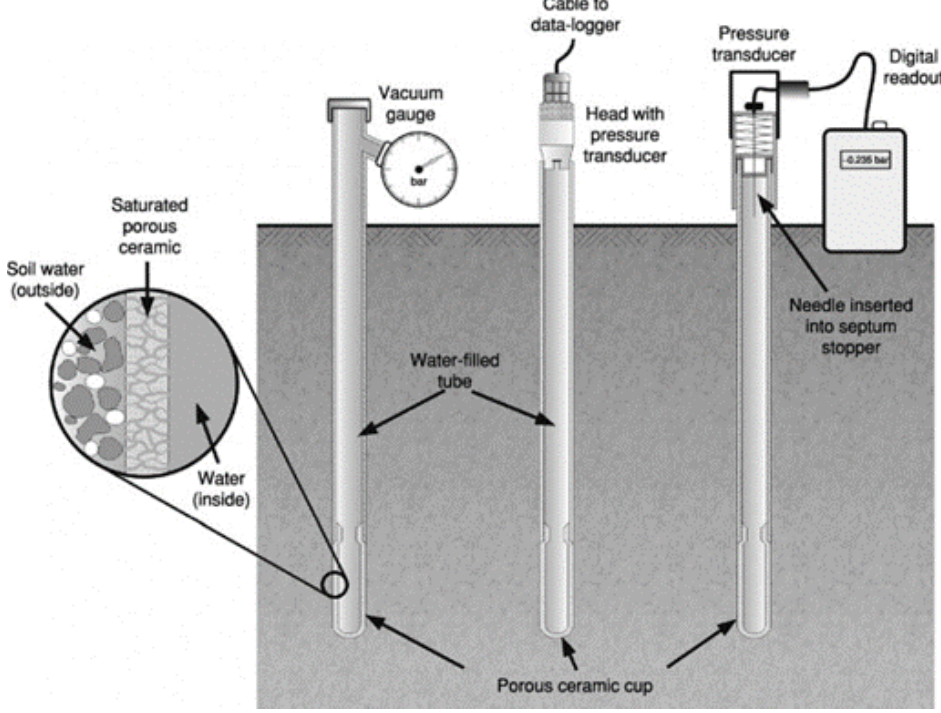
Figure 2. Working scheme of tensiometer sensor, reprinted with permission from Ref. [35], 2022